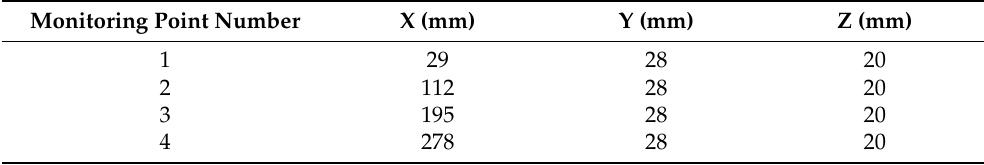
Table 3. Coordinates of temperature monitoring points in the PCM container. Monitoring Point